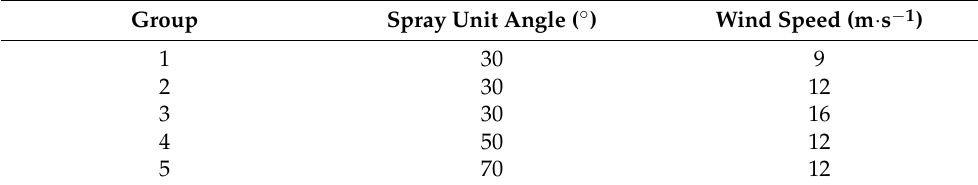
Table 1. The spray parameters of the ASS in the